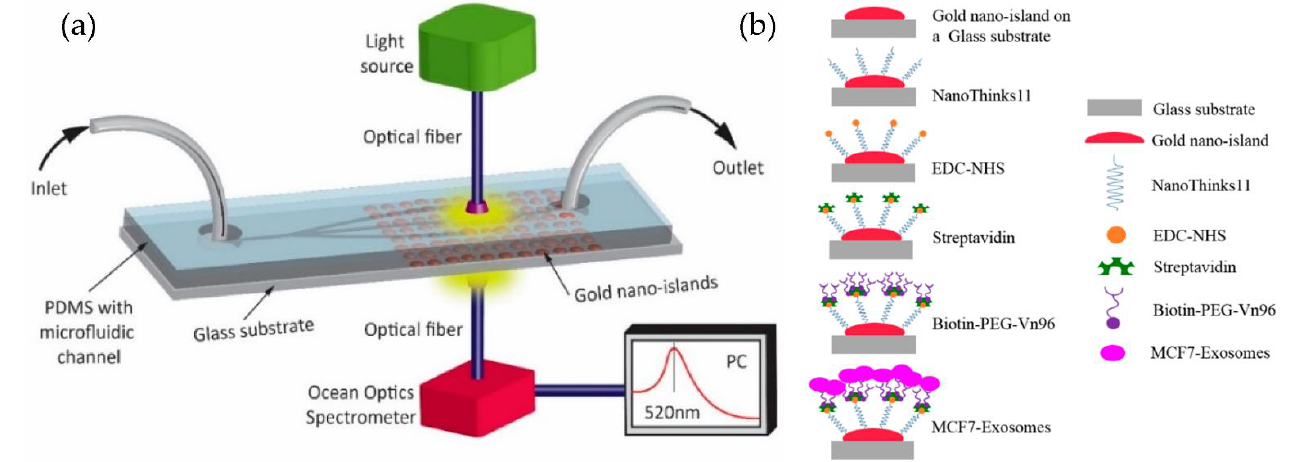
Figure 20. Label-free LSPR microfluidic device to detect MCF-7 exosomes. ( a ) Schematic of the microfluidic device with nano-island structures. ( b ) The biosensing protocol used to detect MCF-7 exosomes (Reproduced from Bathini S. et al. [86]. Copyright 2020, The European J Extracellular Vesicles). Raghu et al. [87] developed a nanosensing array, combining the nano and microfabrica- tion techniques for single exosome detection. As shown in Figure 21, plasmonic nanopillars were fabricated to accommodate at most one exosome. Therefore, to target the tetraspanins CD63 membrane-bound proteins in exosomes secreted by MCF7 breast adenocarcinoma cells, the plasmonic nanopillars were functionalized with anti-CD63 antibodies. Using this over previously reported real-time, multiplexed platforms.